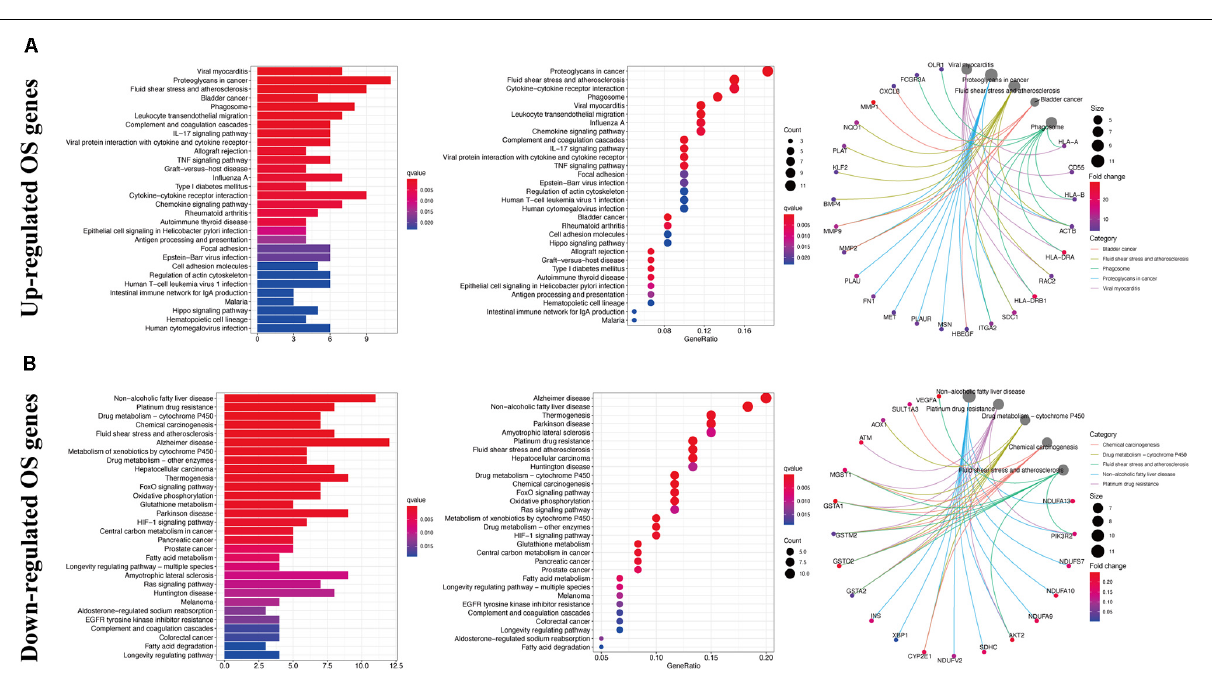
significantly connected with PC patient prognosis and